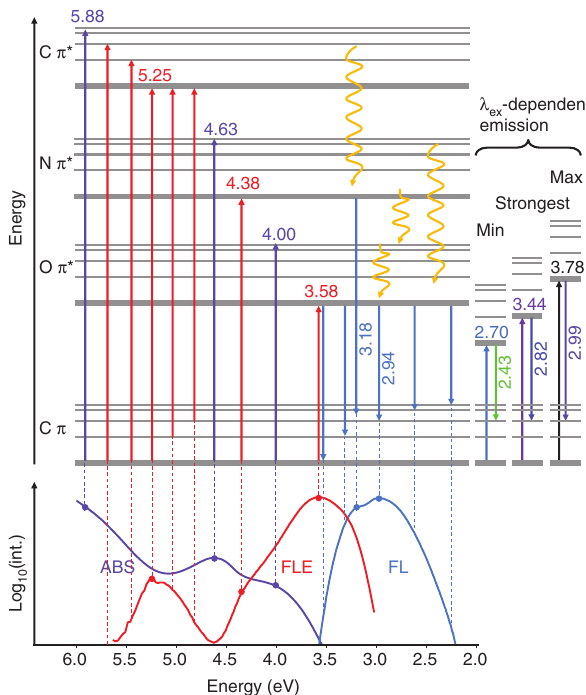
Figure 7: Jablonskidiagram (top panel) representing the energy level structure of NGQDs and the spectra (bottom panel) associated with